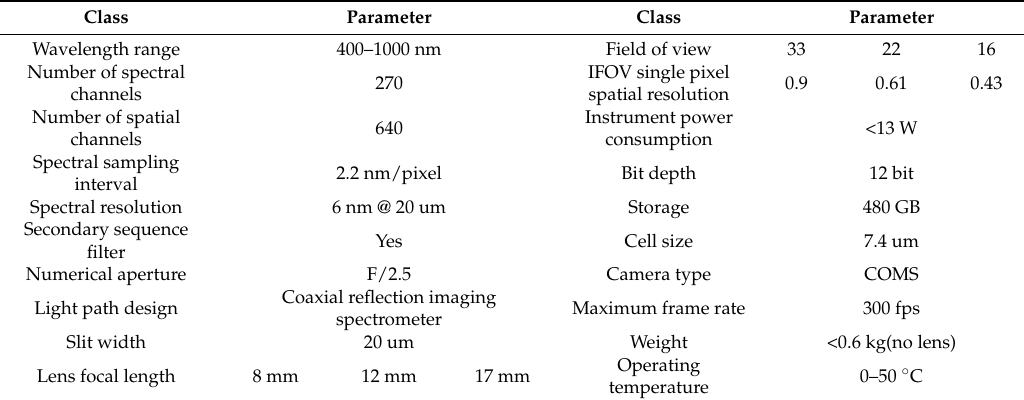
Table 1. Nano-Hyperspec hyperspectral imaging sensor parameter information.